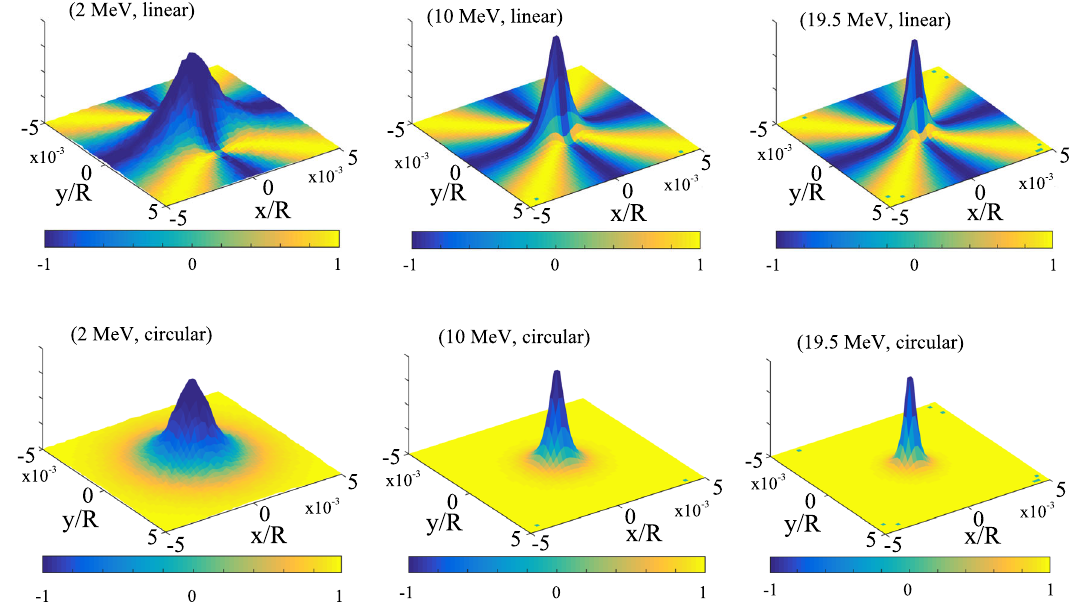
FIG. 9. ELI-NP case: intensity-polarization graphs for photons at 2,10,19.5 MeV, with linear and circular laser